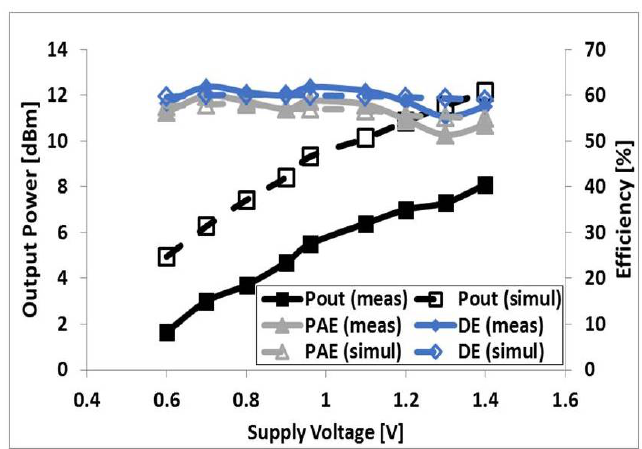
Figure 9. Uncoupled class-E PA: Output power, drain efficiency and power-added efficiency versus the dc supply voltage (measurement: solid black, blue and grey; simulation: dashed white, blue and grey). Drain efficiency (DE) and power-added efficiency (PAE)